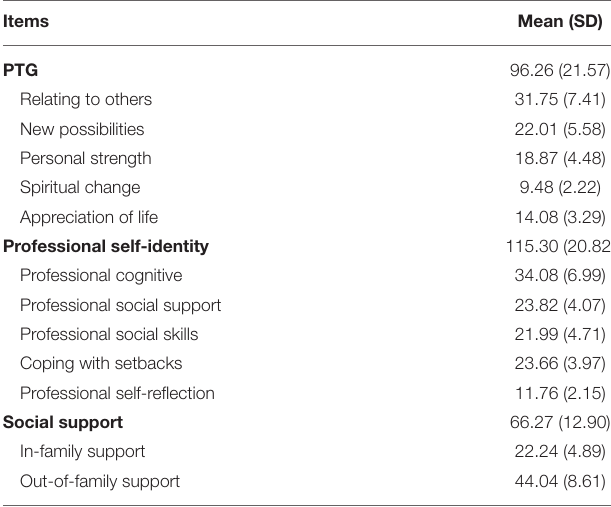
TABLE 1 | Basic information survey form ( N = 266). TABLE 2 | Scores of PTG, Professional Self-identity, and Social Support